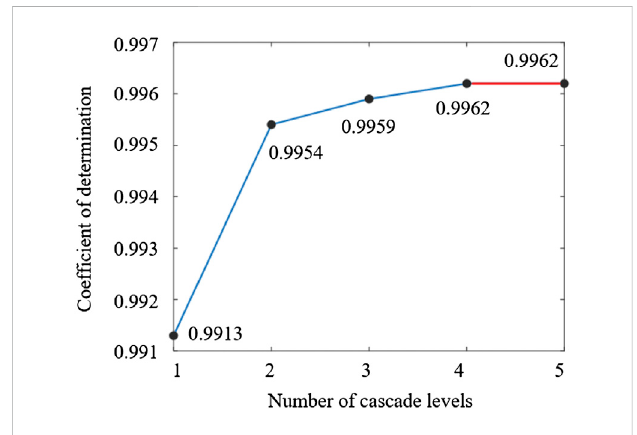
FIGURE 11 Relationship between Z 2 and the number of cascade levels.